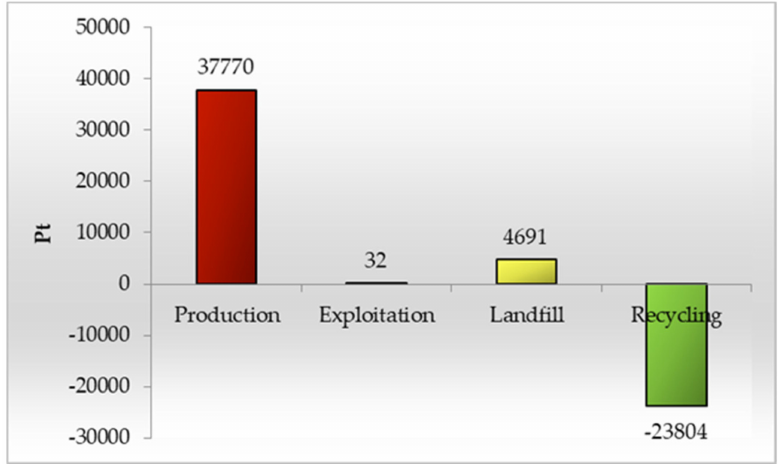
Figure 5. Grouping and weighting results of environmental impacts occurring in the material life cycle stages of a 1 megawatt photovoltaic power plant [unit: Pt].